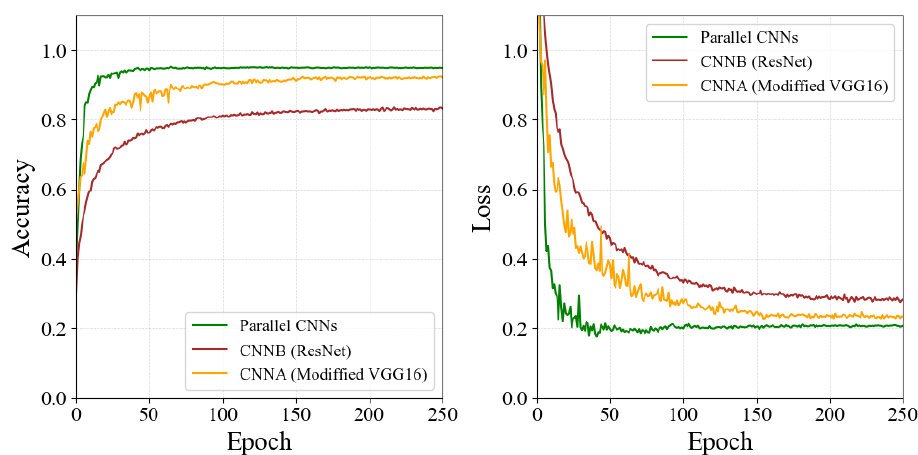
Figure 8. Plots for the convergence in the accuracy and loss of different CNN modules with their composite structures. Table 3. Comparison of different CNN Modules with their composite structures.